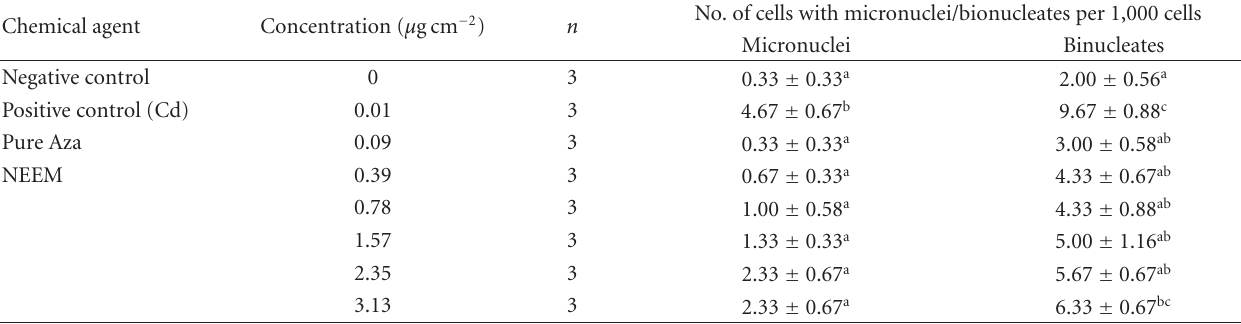
Table 2: Number of micronuclei and binucleates in coelomocytes following a 48-h exposure of Pheretima peguana to commercial neem extract (NEEM), pure Aza, and Cd in a filter paper study.